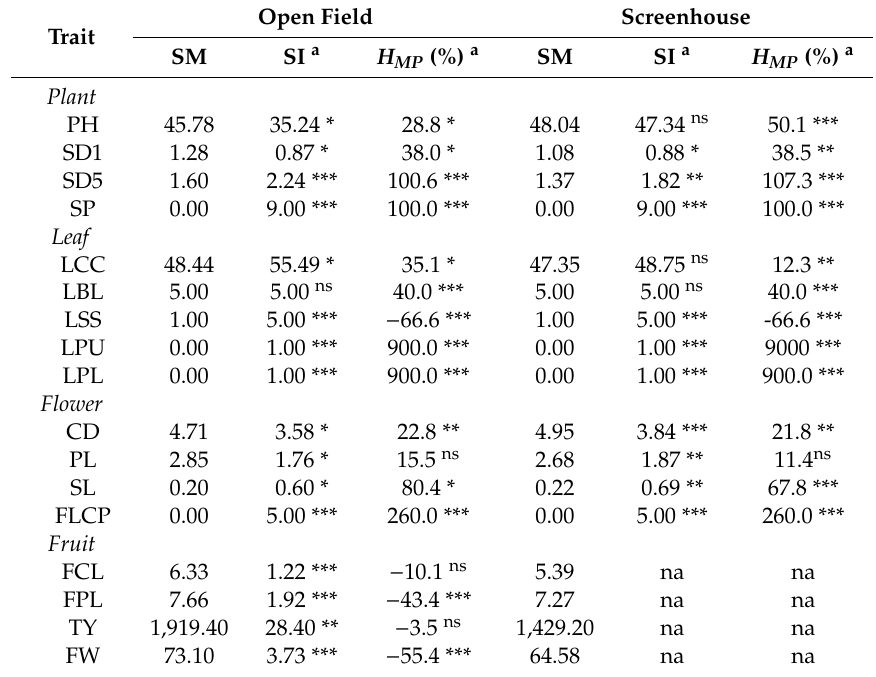
Table 3. Comparison of the mean values of the recipient parent S. melongena AN-S-26 (SM) and